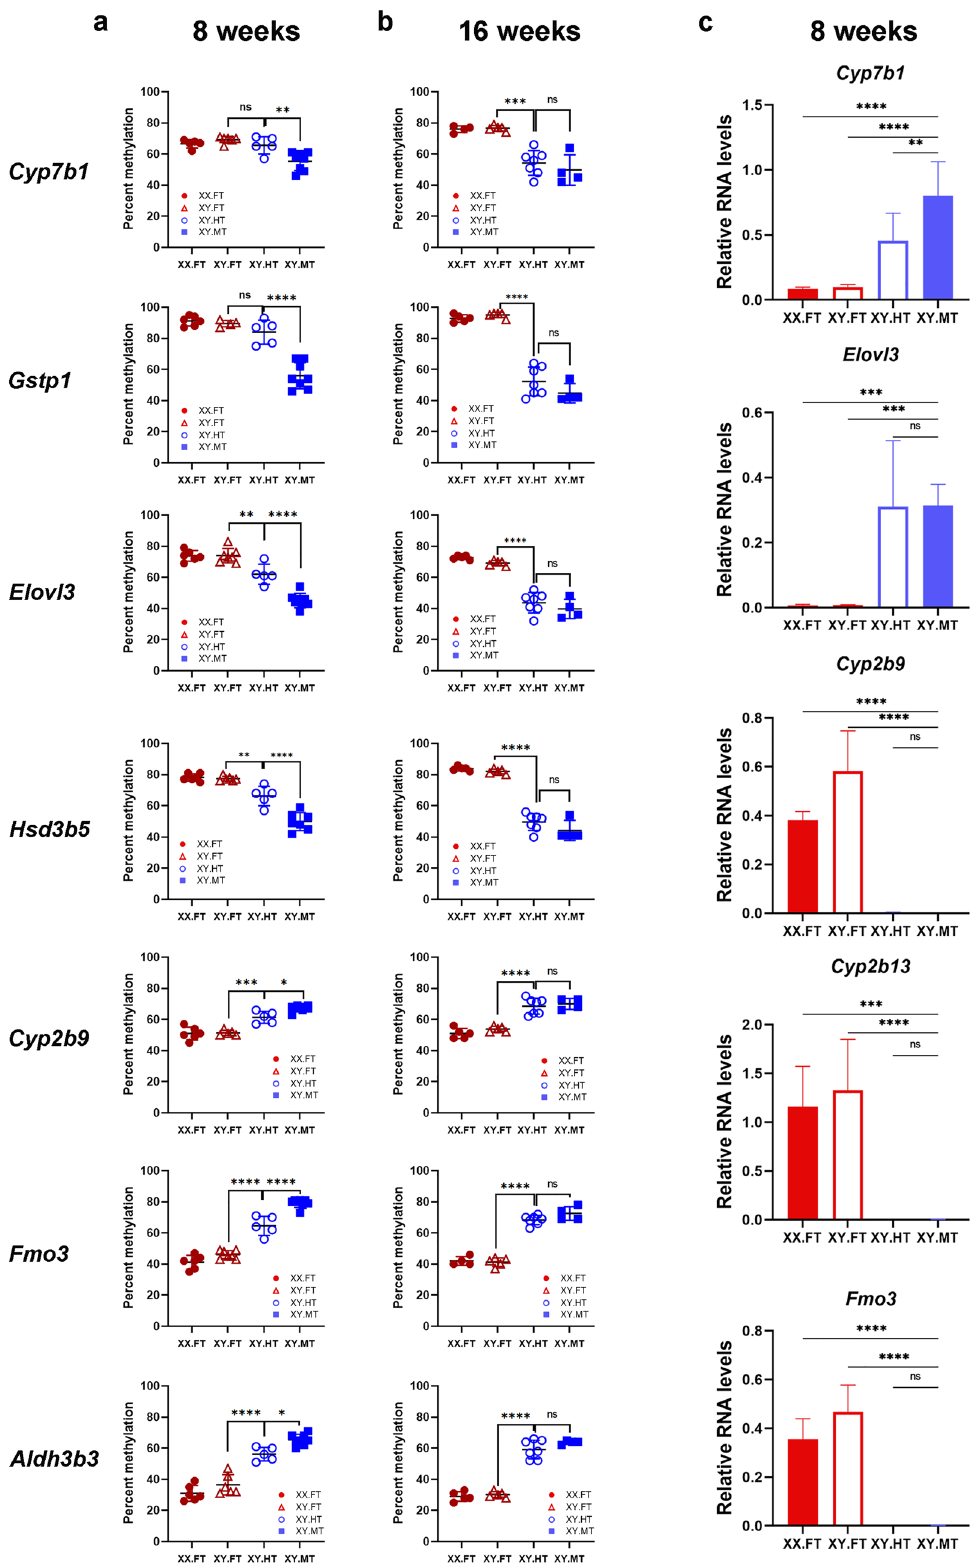
Figure 3. Dynamics of DNA methylation and proximal sDEG expression in hermaphrodites. ( a – b ) DNA methylation levels in true hermaphrodites (XY.HT, n8w = 5, n16w = 7) in comparison to sex-reversed females (XY.FT, n8w = 6, n16w = 5) and males (XY.MT, n8w = 8, n16w = 4) at 8 ( a ) and 16 ( b ) weeks of age. ( c ) Relative expression levels of sDEGs normalized to Rpl19 in 8-week old mice from the B6.Y TIR cross (5 XX.FT, 6 XY.FT, 5 XY.HT, and 8 XY.MT livers). Error bars show standard deviation. Statistically significant differences are shown with asterisks * P < 0.05, ** P < 0.01, *** P < 0.001, **** P < 0.0001, ns: non-significant (one-way ANOVA, followed by multiple testing with Tuckey’s correction). All tested sDMRs were selected based on their previously validated significant differences between females (XX.FT or XY.FT) and males (XY.MT) 6 , hence these differences are not indicated by